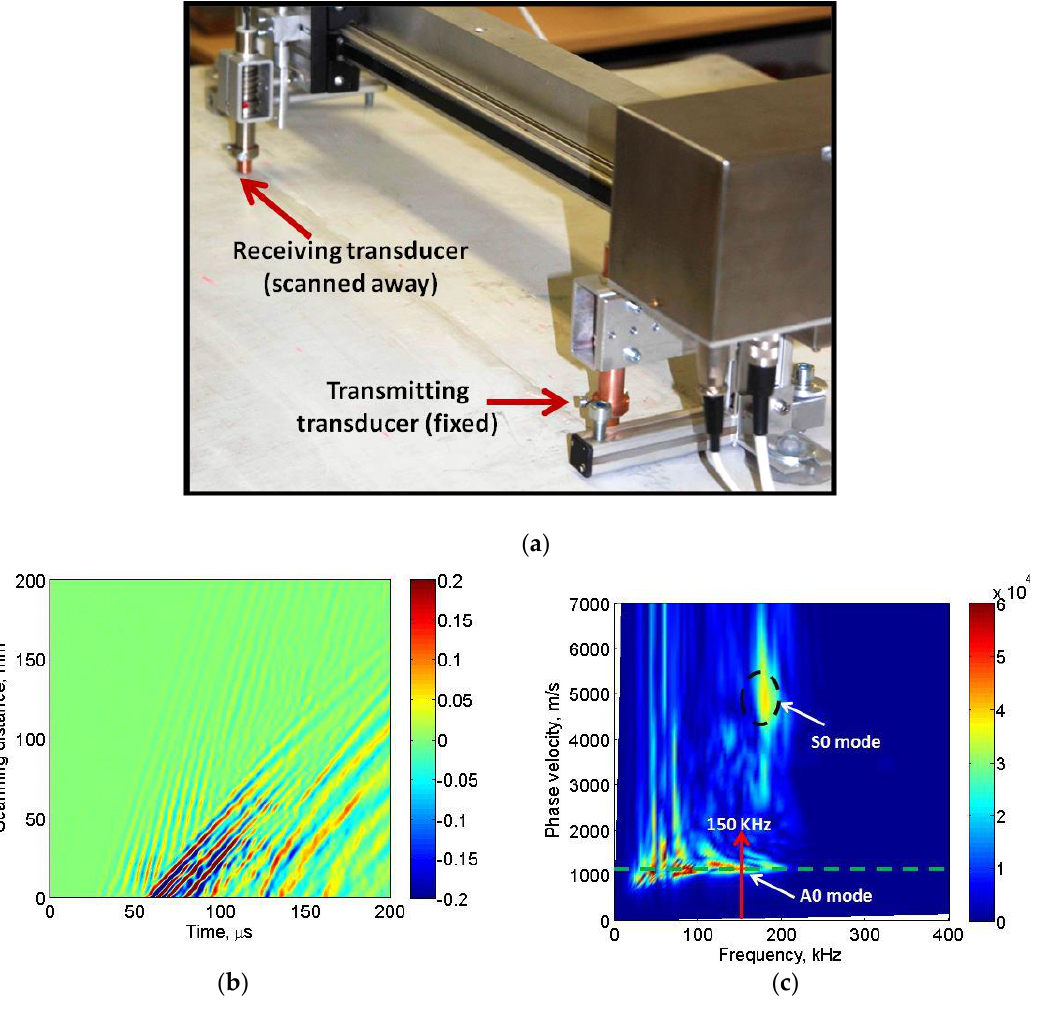
Figure 3. Dispersive characteristics in defect-free region: ( a ) Photograph showing experimental set-up for linear scanning ( b ) the B-scan image; ( c ) dispersion characteristics of phase velocity of propagating modes showing the dominant asymmetric A0 mode and weak S0 mode.